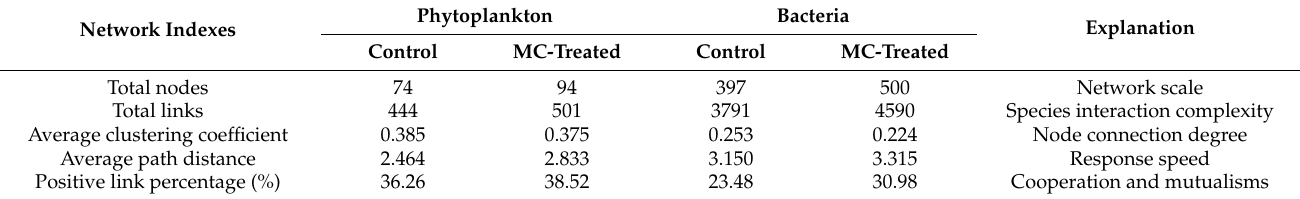
Explanation Cooperation and Explanation